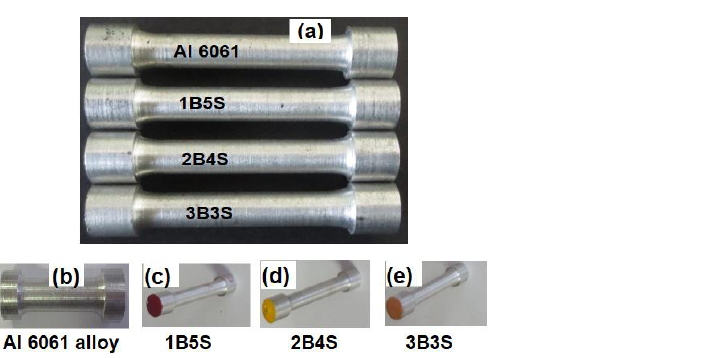
Figure 4. ( a ) Prepared tensile test specimen. ( b ) Al6061 alloy. ( c ) 1B5S, ( d ) 2B4S, ( e ) 3B3S compo- sites.